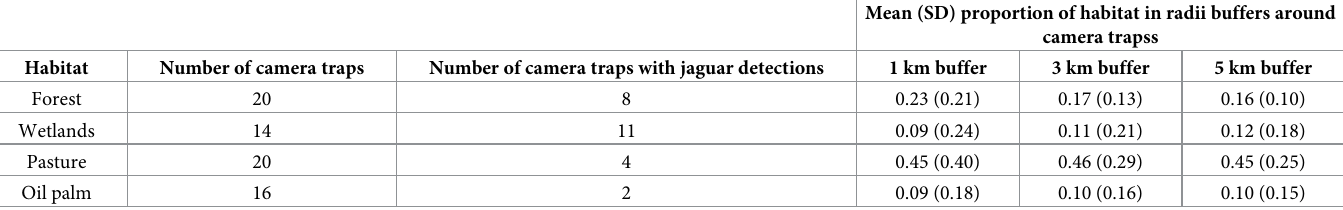
Table 1. Camera trap placement by habitat type. Includes jaguar detections and mean values of habitat covariates at camera trap sites (n = 70) in the middle Magdalena River valley, Colombia.